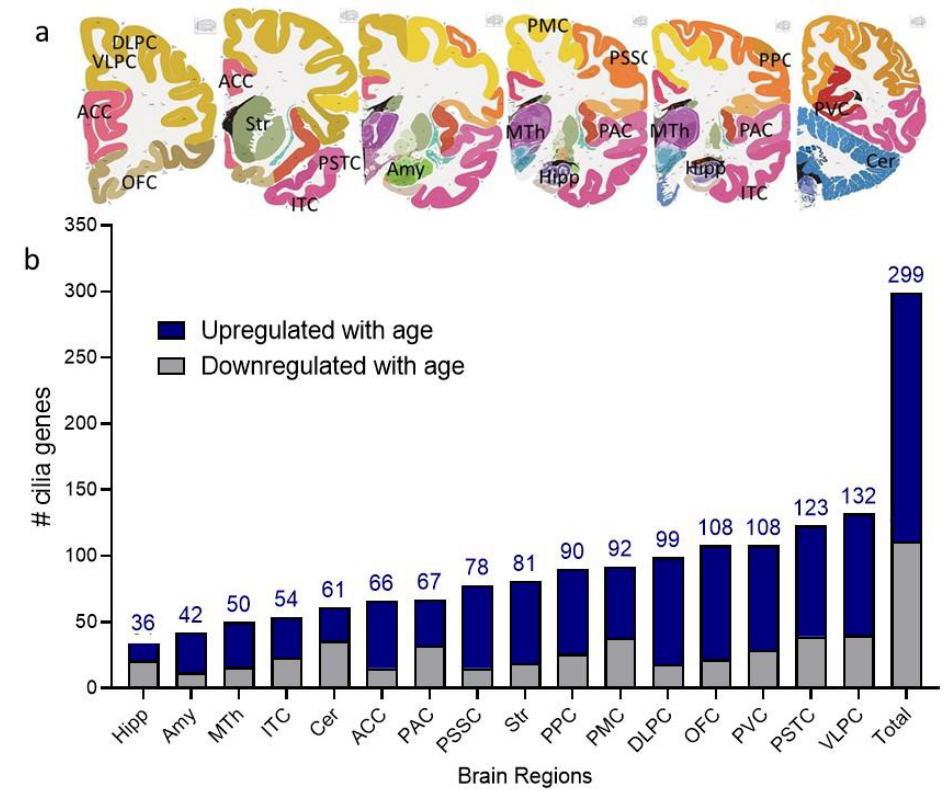
Figure 1. Age-dependent gene expressions of cilia genes abundance in the human brain. ( a ) Representative brain section from human brains (BrainMaps: An Interactive Multiresolution Brain Atlas; http://brainmaps.org [retrieved on 2 August 2021] [26] showing the regions and nuclei from which tissues were collected: anterior (rostral) cingulate (medial prefrontal) cortex (ACC), amygdaloid (Amy), Cerebellar cortex (Cer), dorsolateral prefrontal cortex (DLPC), Hippocampus (Hipp), Inferolateral temporal cortex (area TEv, area 20) (ITC), Mediodorsal nucleus of the thalamus (MTh), Orbital frontal cortex (OFC), posterior (caudal) superior temporal cortex (area 22c) (PSTC), posteroventral (inferior) parietal cortex (PPC), pri- mary auditory cortex (core) (PAC), primary motor cortex (area M1, area 4) (PMC), primary visual cortex (striate cortex, area V117) (PVC), primary somatosensory cortex (area S1, areas 3,1,2) (PSSC), Striatum (Str), and ventrolateral prefrontal cortex (VLPC).( b ) Stacked bar chart shows the total number of cilia genes that are differentially expressed with age (cilia DEGAs) in the whole brain and each of the 16 brain regions, with the exact number of cilia DEGAs that are upregulated and downregulated. The numbers on the top of bars represent the number of DEGAs in brain regions. Among all cilia DEGAs, SNAP-25 exhibited the highest linear regression coefficient compared to other cilia genes in any given brain region, with the highest regression coef- ficient value in PVC (22.3) (Figure 2a–p, Table S2). Around a four-fold increase in SNAP- 25 expression in the PVC between the first 5-year age group (0–5 years) and the last age group (36–40). On the other hand, genes encoding α-tubulin subunit ( TUBA1A ) and β- tubulin subunits ( TUBB2A and TUBB2B ) exhibited the top negative coefficients, with a region-specific distribution of either one or more of these tubulin subunits. For example, in the thalamus and most cortical regions, both TUBA1A and TUBB2A/TUBB2B exhibited the highest negative slopes among cilia DEGAs, with TUBA1A displaying a higher abso- lute coefficient than TUBB2A/TUBB2B in these regions (Figure 2a–p, Table S2). Genes en- coding β-tubulin subunits TUBB2A/TUBB2B exhibited the highest negative coefficient in